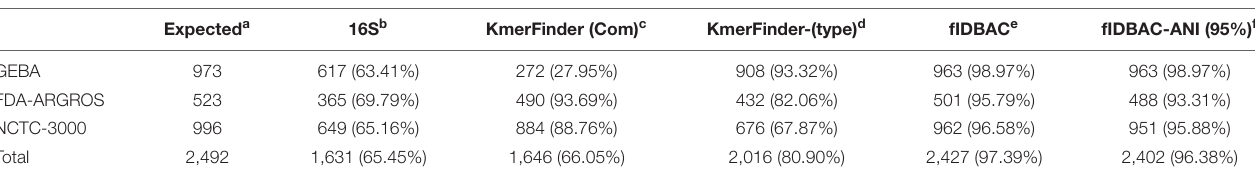
FIGURE 1 | Brief summary of fIDBAC database. (A) Number of genomes in each phylum. (B) Distribution of genome size in the fIDBAC database. (C) Distribution of GC content in the fIDBAC database. (D) Distribution of pairwise ANI values between any of two assemblies in the fIDBAC database. TABLE 1 | Accuracy of different methods on GEBA, FDA-ARGROS, and NCTC 3000